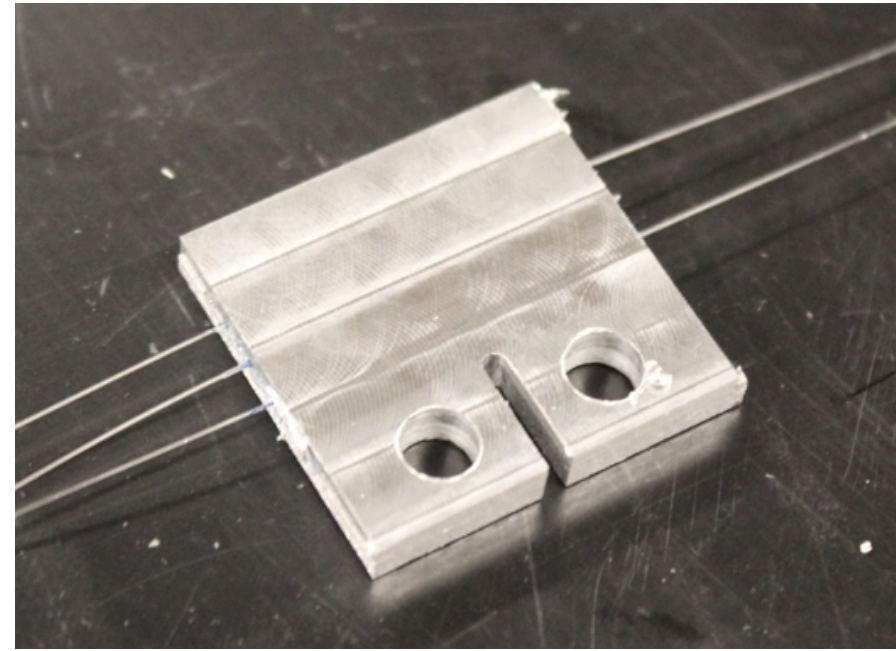
Figure 6. Compact tension (CT) specimen with three embedded FBG sensors built using UAM used in prognostic testing. The sensors are located 3 mm, 6 mm, and 9 mm from the tip of the